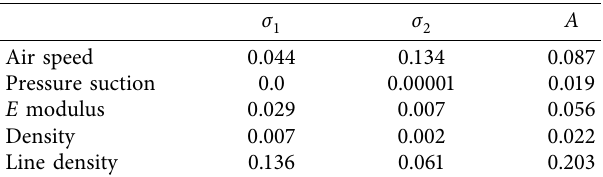
Figure 11: Effect of the input material parameters on the fiber laydown characteristics: the effect of E modulus (a) and the effect of the density (b) are on the same order of magnitude, while the effect of the line density is approximately 10 times bigger than the effect of E modulus and density (c). Table 1: Average elasticity measures (dimensionless quantities) computed due to